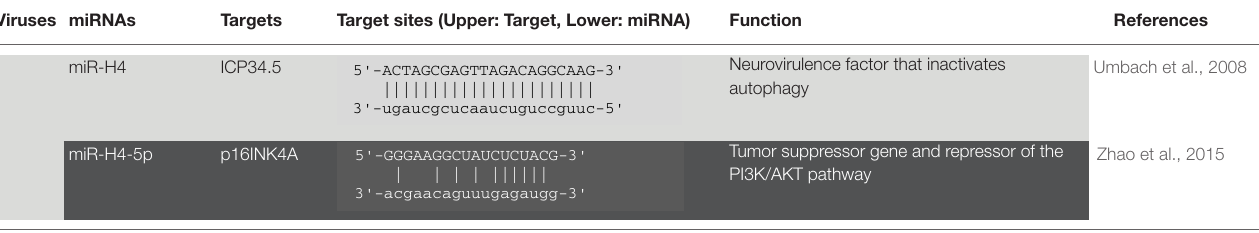
13 precursor (pre)-miRNAs. These KSHV miRNAs are